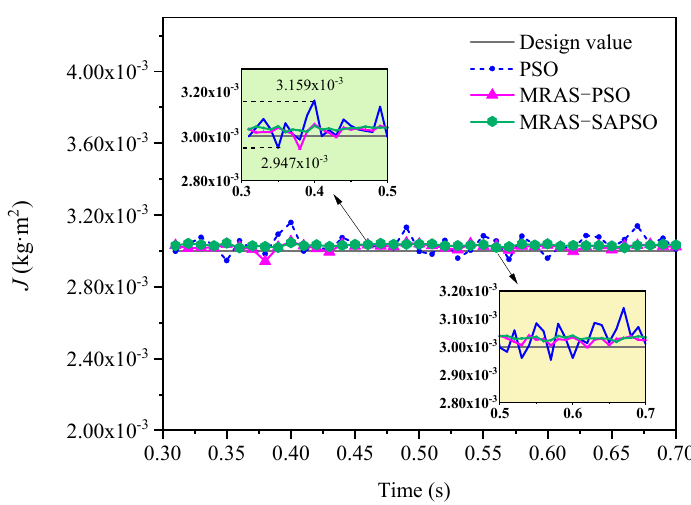
Figure 12. Moment of inertia identification curve.